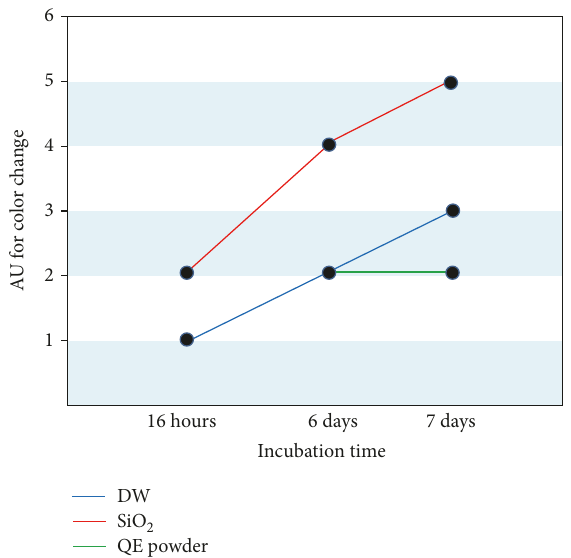
Figure 5: Variation of color of the bean sprout stems with incubation time . Arbitrary unit (AU) in 5-point scale is adopted to indicate the color change, that is, from AU1, white, and no change in color, to AU5, dark brown, and severely